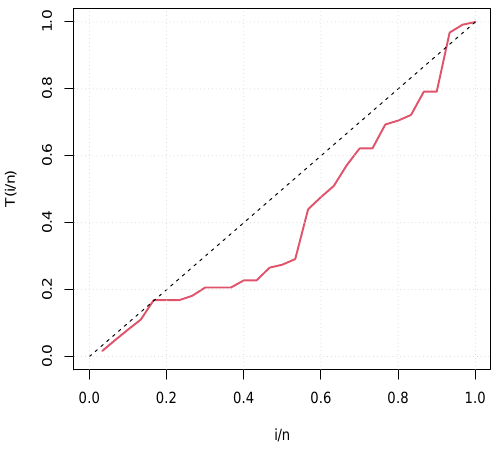
Figure 6. TTT plot of the failure times data set.